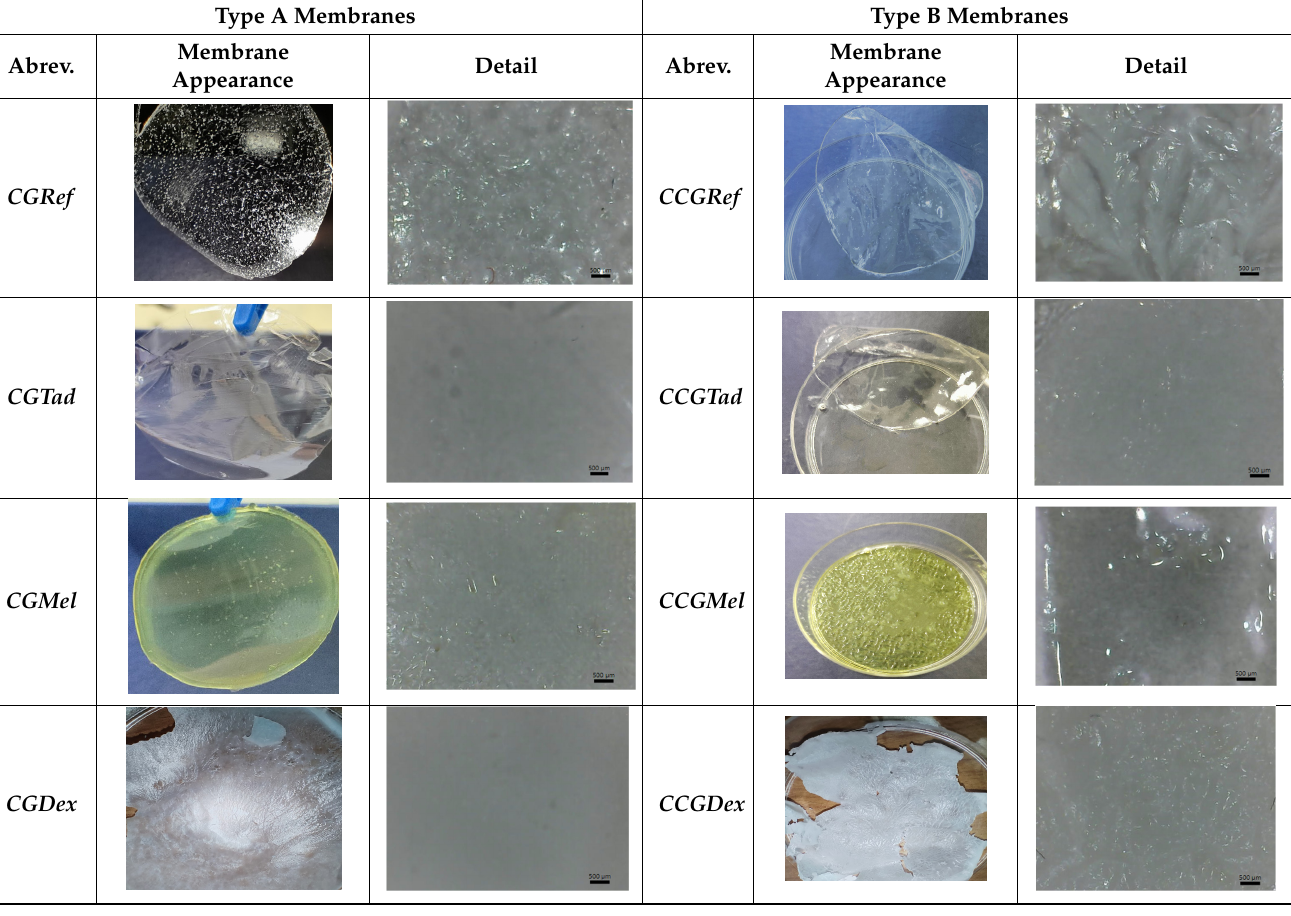
Table 1. Type A and type B membranes with different anti-inflammatory drugs and their appearance.